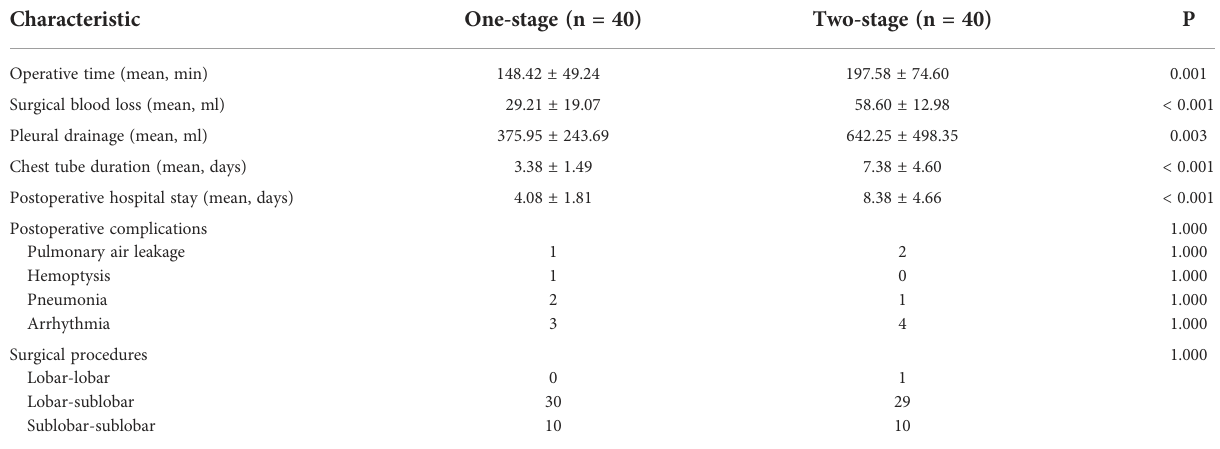
TABLE 2 Comparison of perioperative clinical data of the two groups. Characteristic